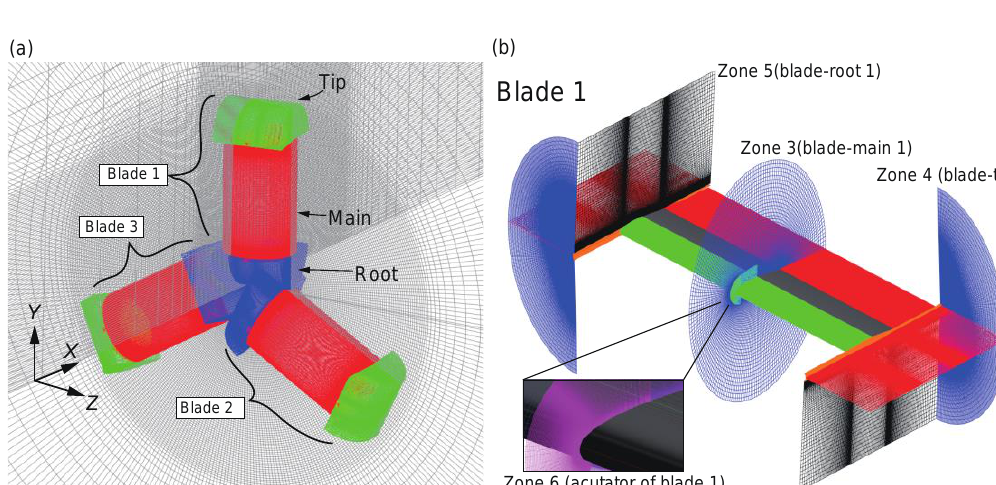
Figure 4. Computational grids around the model: ( a ) overview; ( b ) near blade 1.